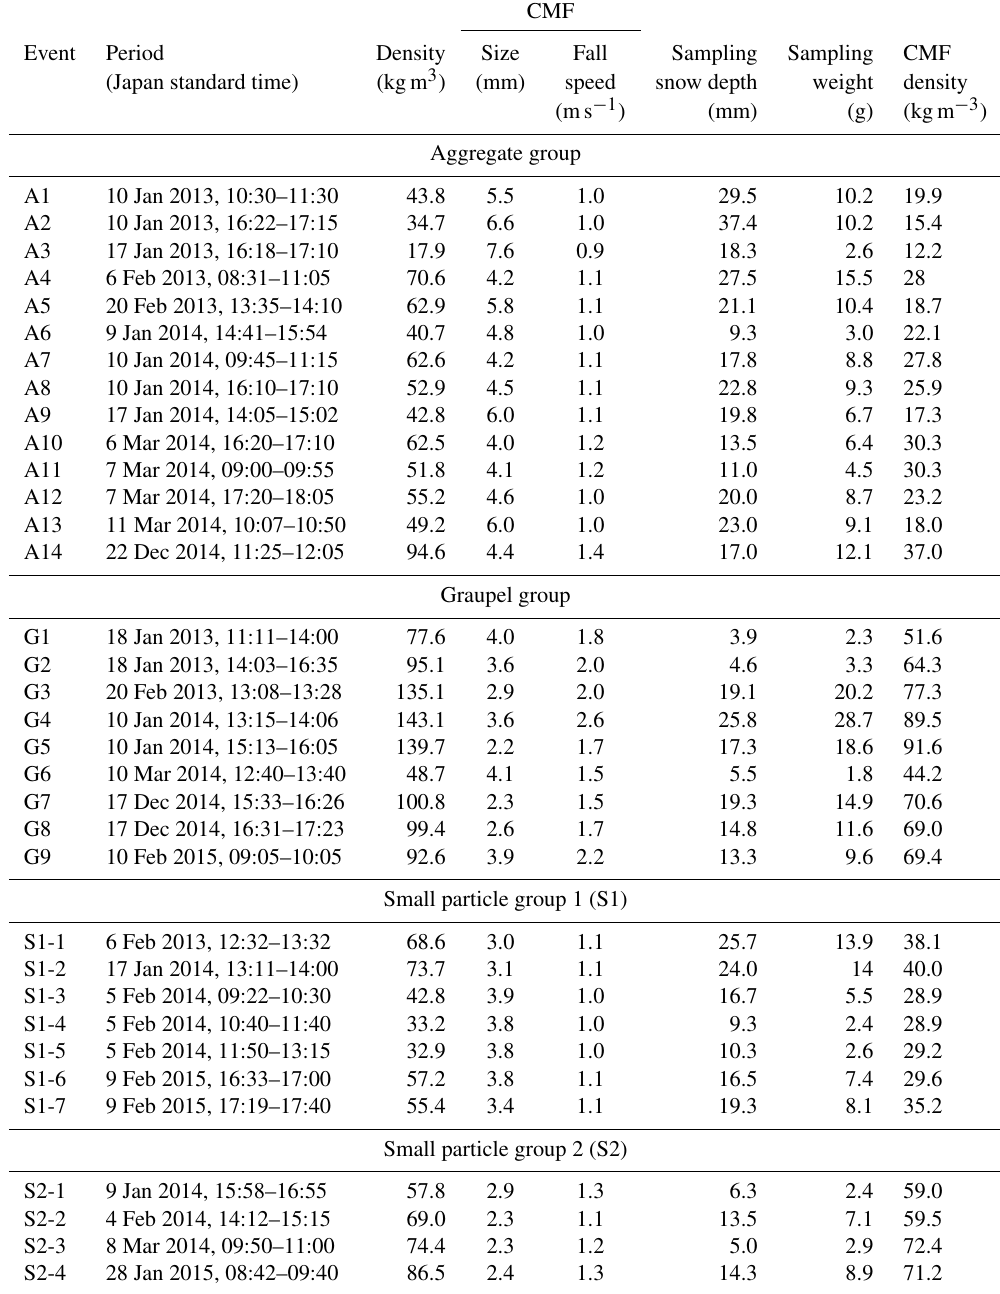
Table 1. Characteristics of selected snowfall events, classified into four groups based on snow type, where A is aggregate, G is graupel, S1 is small particle group 1, and S2 is small particle group